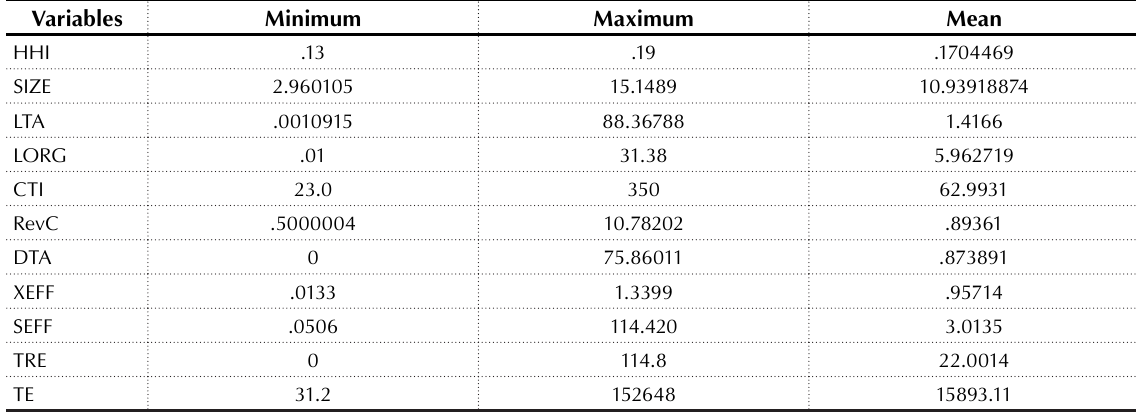
Table 1. Summary